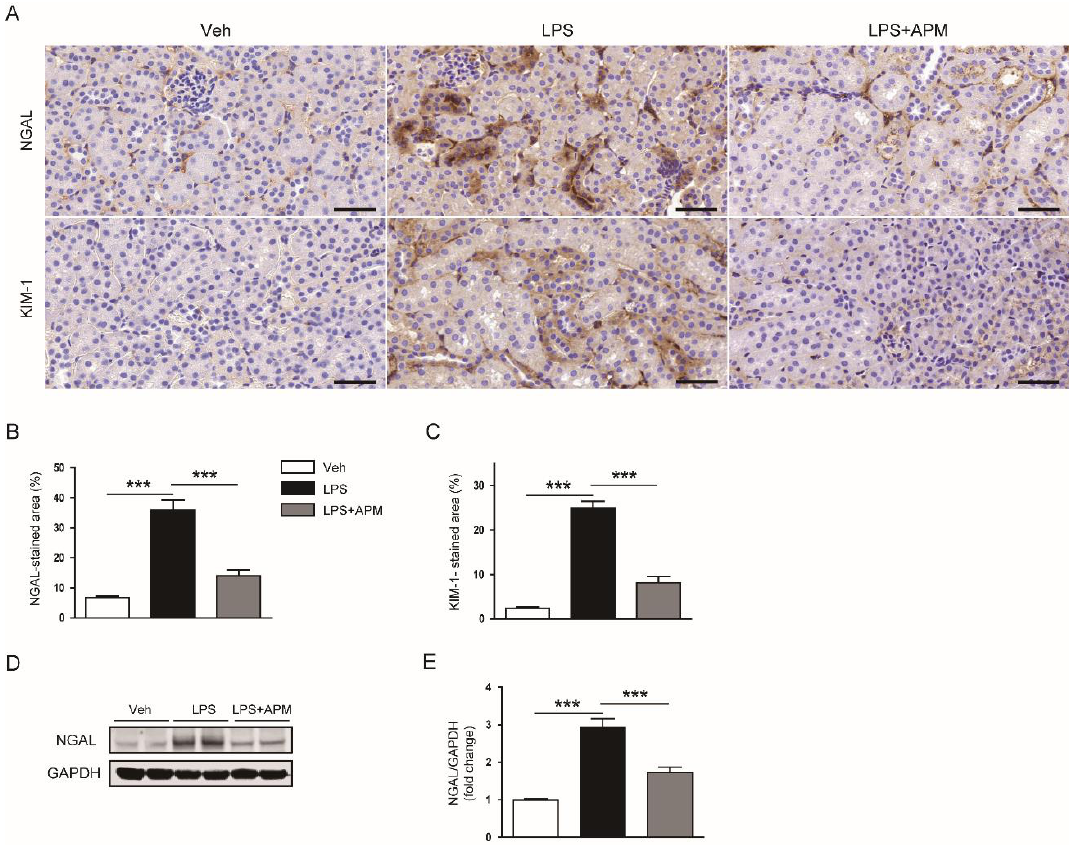
Figure 4. Effect of apamin on expression of tubular injury markers in LPS-injected mice. ( A ) Immunohistochemical staining of kidney tissues for neutrophil gelatinase-associated lipocalin (NGAL) or kidney injury molecule-1 (KIM-1). Scale bars: 50 μm. ( B ) Percentage of stained areas for NGAL. ( C ) Percentage of stained areas for KIM-1. ( D ) Immunoblotting of NGAL. ( E ) Quantification of immunoblot for NGAL. n = 8 per each group. *** p < 0.001.